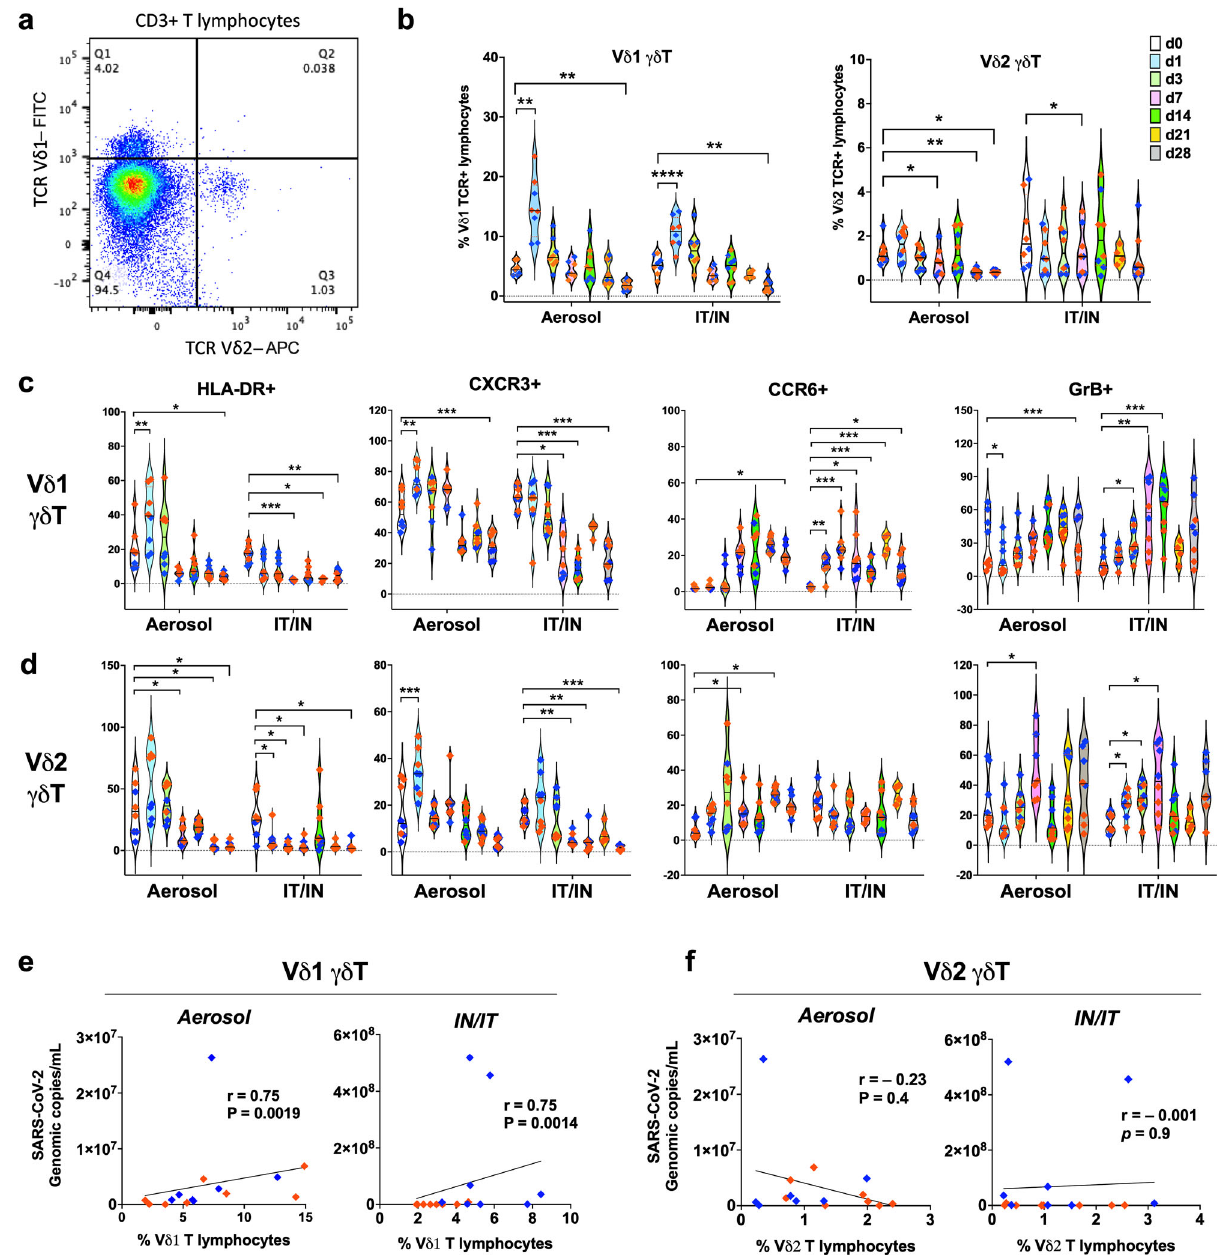
Fig. 5 Dynamic changes in circulating V δ 1 and V δ 2 γδ T cell subsets and association with BAL viral loads during early SARS-CoV-2 infection. a Representative FACS plot of PBMC showing gating for V δ 1 and V δ 2 γδ T cell subsets in CD3 + T lymphocytes. b Frequencies of V δ 1 (left) and V δ 2 T cell subset (right) in PBMC following SARS-CoV-2 infection via aerosol or IT/IN routes ( n = 8/group) on days 0, 1, 3, 7, 14, 21, and 28. Expression levels of HLA-DR, CXCR3, CCR6, and GrB on Vd1 T cells ( c ), and Vd2 T cells ( d ). Graphs show mean and SEM. Comparisons of different time points with respect to d0 baseline data were done using two-way ANOVA with mixed effects model and Dunnett ’ s post hoc tests. Asterisks indicate signi fi cant differences between time points (* p < 0.05; ** p < 0.01; *** p < 0.001; **** p < 0.0001). Spearman Rank correlation between BAL viral loads in the fi rst week (d1 and d7) with corresponding frequencies of V δ 1 T cells (e), and V δ 2 T cells (f) showing signi fi cant correlations for V δ 1 T cells in both aerosol and IT/IN groups (n = 16/group). Individual values shown for each animal as symbols in orange for RMs and blue for CD8 T cells paralleled the early in fl ammatory response in lungs (Fig. 8b). However, signi fi cant negative correlations of V δ 1 T cell of IT/IN exposed animals. frequencies were noted with MIP-1 α (Fig. 8b), also a monocyte/ Further evaluation of the correlations between γδ T cell macrophage chemotactic cytokine. Since MIP-1 α is reportedly frequencies and BAL cytokines in aerosol vs IT/IN exposure higher in mild to severe cases than asymptomatic SARS-CoV-2 groups revealed that levels of MCP-1 (monocyte chemotactic infections 29 , this suggests a positive association of lung V δ 1 T cell numbers with asymptomatic infection. Notably, aerosol infection factor regulating the migration and in fi ltration of monocytes, displayed a signi fi cant correlation of V δ 1 T cells with IL-1Ra, memory T cells, and NK cells) signi fi cantly correlated with BAL which blocks in fl ammatory effects of IL-1 cytokines (Fig. 8b). V δ 1 T cell frequencies at 14dpi in both routes of exposure